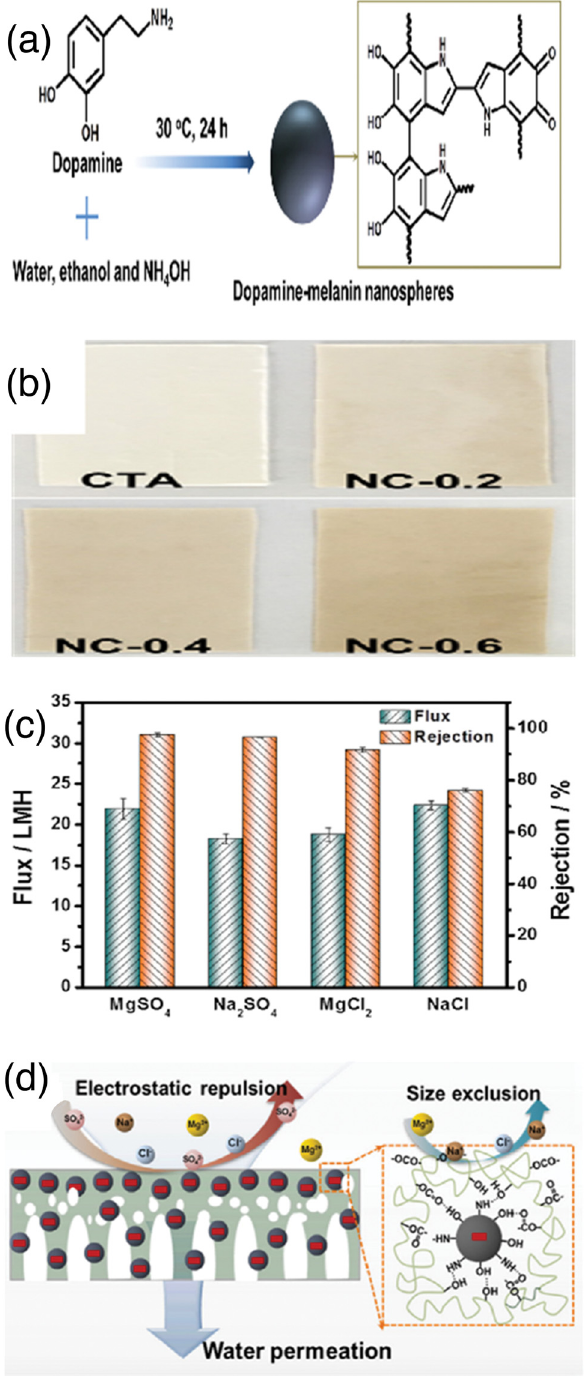
Figure 3: ( a ) Schematic diagram of the synthesis of dopamine - melanin nanospheres, ( b ) CTA and nanocomposite fi lm loaded with di ff erent dopamine - melanin nanospheres, ( c ) water fl ux and inter - ception rate of NC - 0.4 fi lm for MgSO 4 , Na 2 SO 4 , MgCl 2 and NaCl solution and ( d ) separation mechanism of nanocomposite fi lm [ 108 ] .